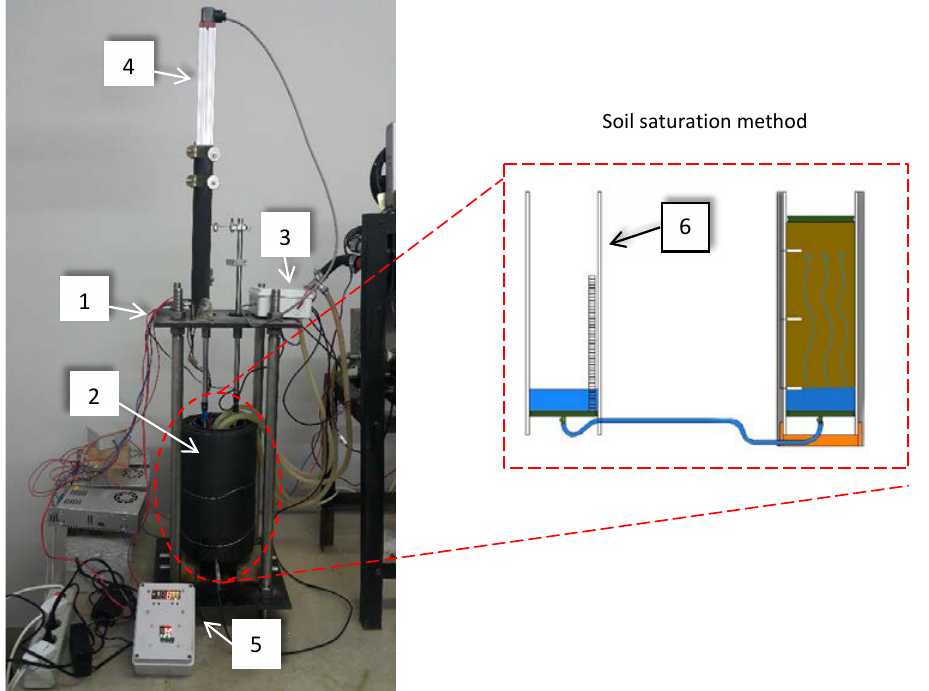
Fig. 2: Frost heave testing apparatus: main frame (1), insulated specimen cylinder (2), data processor and recorder (3), displacement sensor (4), temperature control panel (5), and water tank (6)